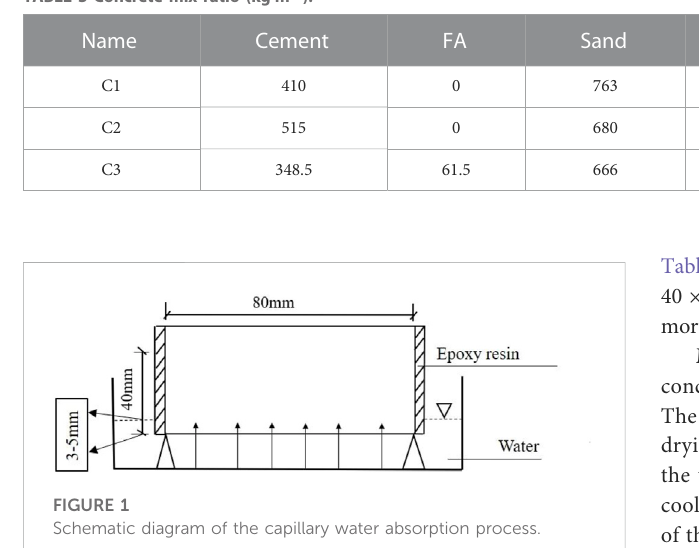
TABLE 3 Concrete mix ratio (kg · m − 3 ).